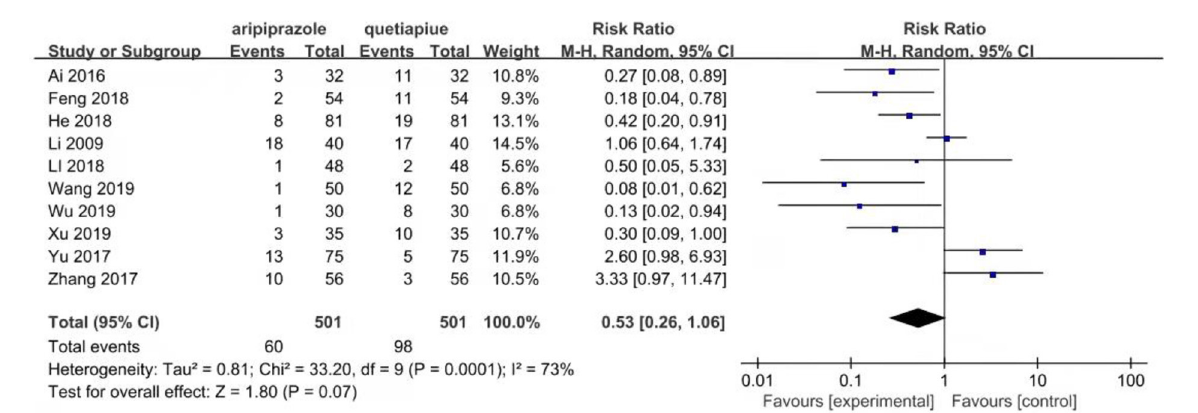
FIGURE9 Comparison of the drop out rate between aripripazole and quetiapine group. The drop out rate is an indicator of drug side effects or acceptance to drug, which was analyzed by random effect model due to their heterogeneity ( X 2 = 33.20, df = 9, P = 0.0001, I 2 = 73%). The results show that drop out rate of aripripazole was similar to quetiapine (Z = 1.80, P =